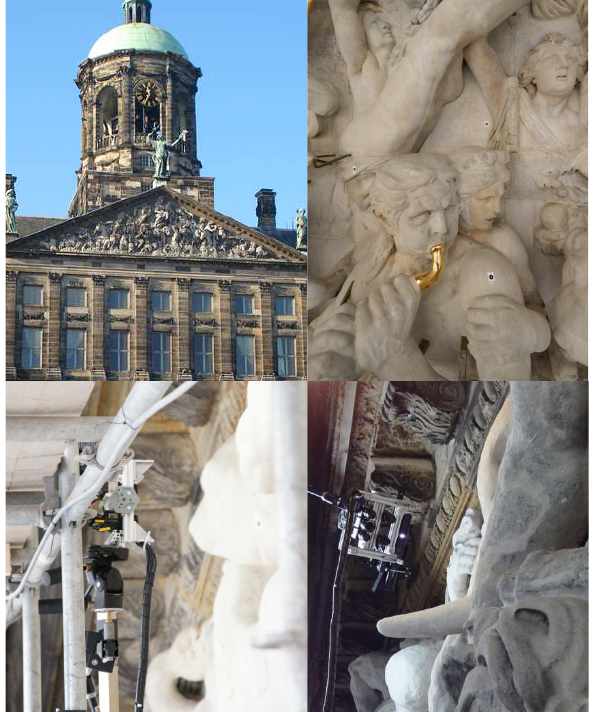
Figure 7: Upper left: East tympanum at the palace of Amsterdam from distance. Upper right: detail - the relief contains whole statues (size of visible target: 4cm by 3cm). Lower: sensor during data